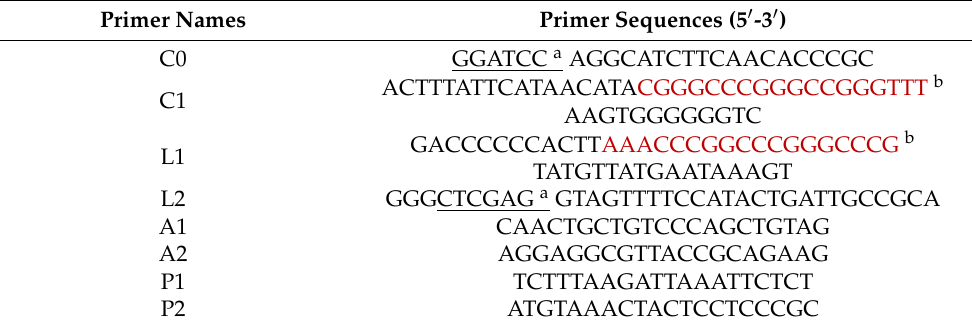
Figure 1. Schematic diagram of the construction of DNA plasmids. ( a , b ) The genes Cap and LTB were amplified with the plasmid pMD18-Ts-Cap/LTB fused by polymerase chain reaction (PCR) and then inserted into the vectors pPG611.1 or pPG612.1 at BamH I and Xho I sites, generating plasmids pPG611.1-Cap-LTB and pPG612.1-Cap-LTB. Table 1. Sequences of the